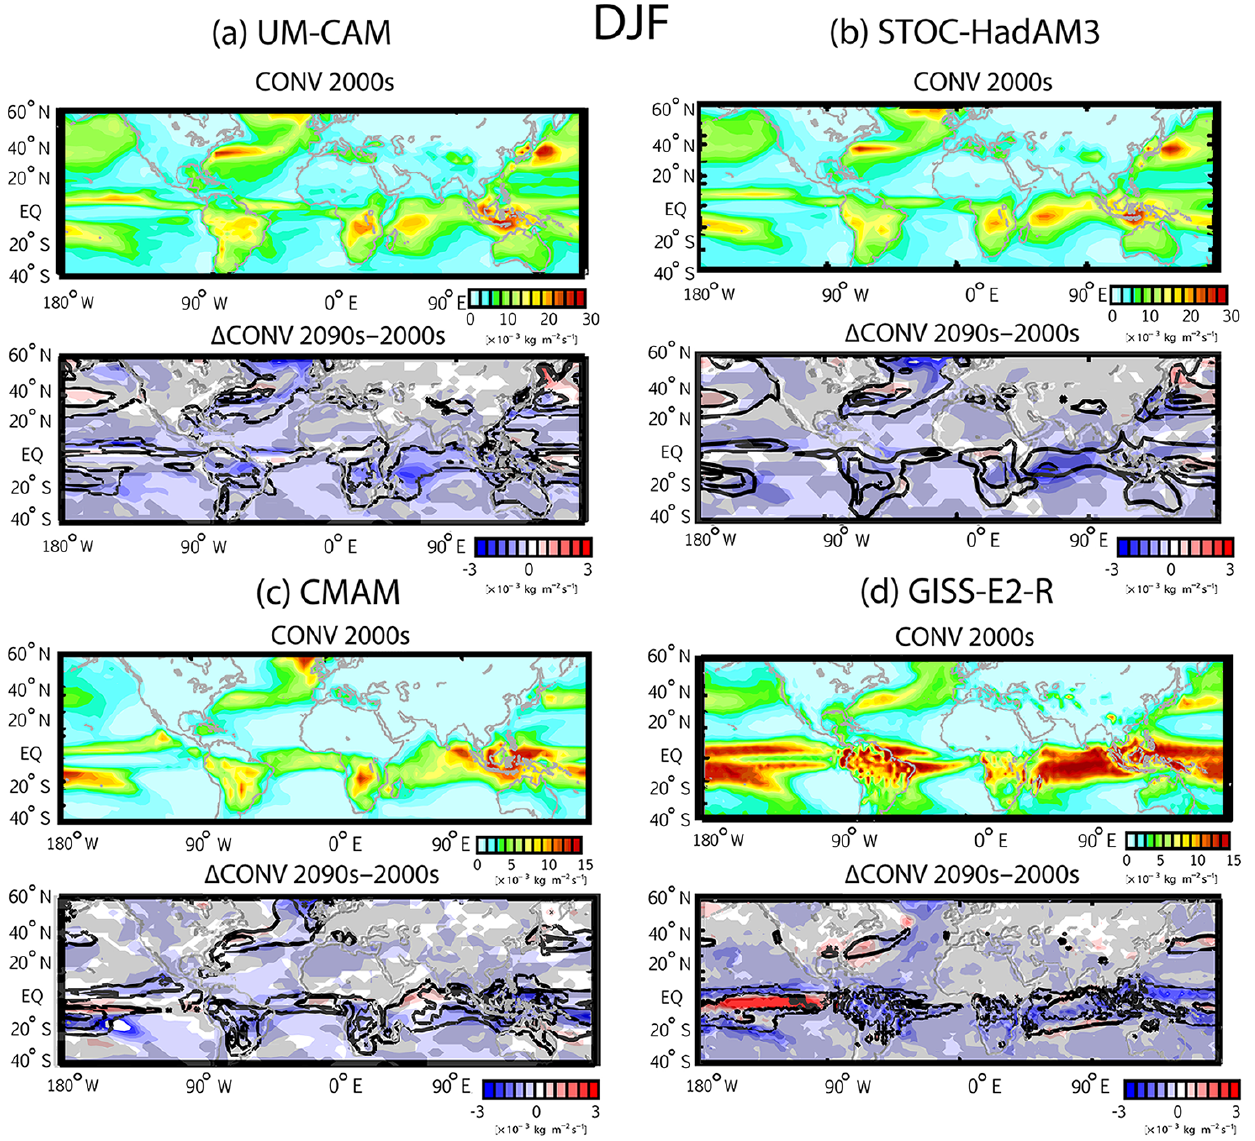
Figure 8. Top panels within subplots (a–d) : DJF 10-year climatological mean convective mass fluxes, averaged over 300–800hPa for 1996– 2005 (present day). Bottom panels: differences between 2090–2099 (RCP 8.5) and 1996–2005 (present day) DJF climatological mean convective mass fluxes, wherein black contours denote the present-day climatology. Results are presented for UM-CAM and STOC-HadAM3 (top panels) and CMAM and GISS-E2-R (bottom panels). Grey shading indicates where results are not significant at p < 0 . 05 as evaluated with a Student’s t test using 10 years of data for the 2090s (RCP 8.5) and present-day simulations. Note the different scales for (i) UM-CAM and STOC-HadAM3 and (ii) CMAM and